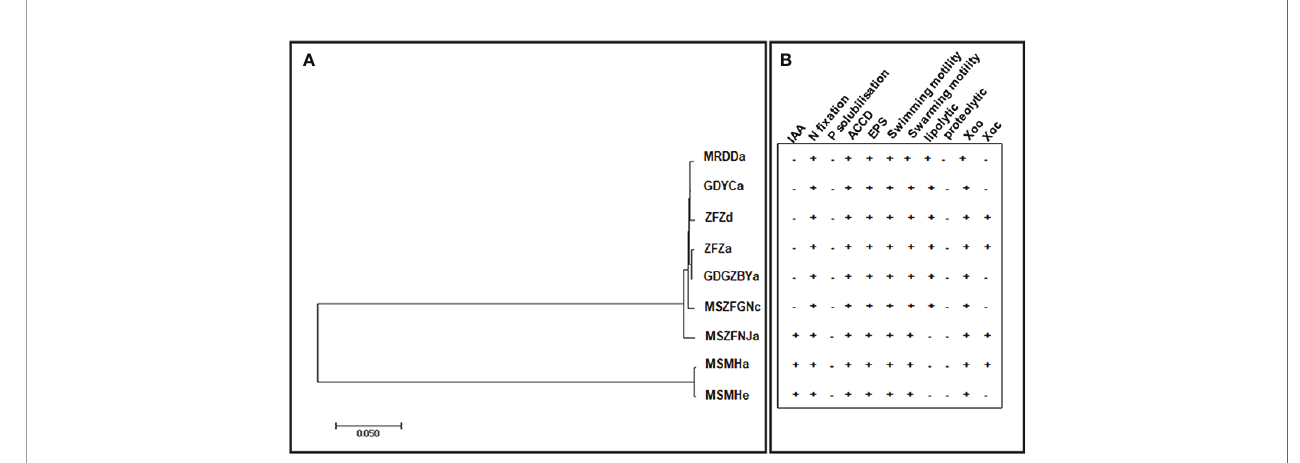
FIGURE 4 | The NJ tree based on full-length 16S rRNA gene and the PGP traits of the endophytic Pantoea sp. isolates. (A) The NJ tree reconstructed based on the full-length of 16S rRNA gene sequences of Pantoea sp. strains by MEGA (version 7.0.21). (B) Characterization of in vitro plant growth-promoting traits. IAA, indole acetic acid production; N, nitrogen fi xation; P, phosphorous solubilization; ACCD, ACC Deaminase activity; EPS, exopolysaccharide production. Swimming and swarming motility, lipolytic and proteolytic activity, and antibacterial activity against Xoo and Xoc . Each experiment was performed with three biological replicates. Positive detection (+), negative detection ( − ).